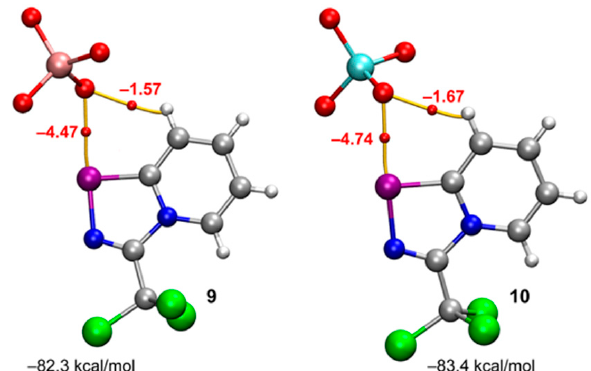
Figure 6. QTAIM analyses of compounds 9 and 10 . Only intermolecular bond CPs and bond paths are represented. The interaction energies of the ChB and HB contacts are indicated next to the bond CPs (small red spheres) in kcal/mol.